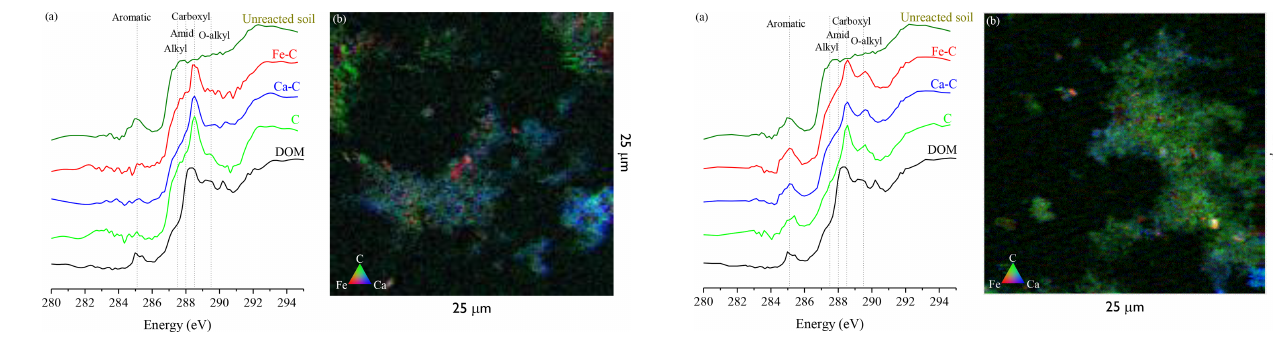
Figure 5. JRB soil reacted with DOM under wet–dry cycling. (a) C NEXAFS spectra extracted from C, Ca and Fe regions of STXM map. Spectra of unreacted soil (top) and DOM solution (bottom) are presented. Dashed vertical lines point out C species. (b) Tri-colored STXM map of fine fraction from JRB soil reacted four times with DOM under wet–dry cycling; Fe (red), Ca (blue) and C (green). Image size 25µm × 25µm. For color rendering of this image please refer to the online version.